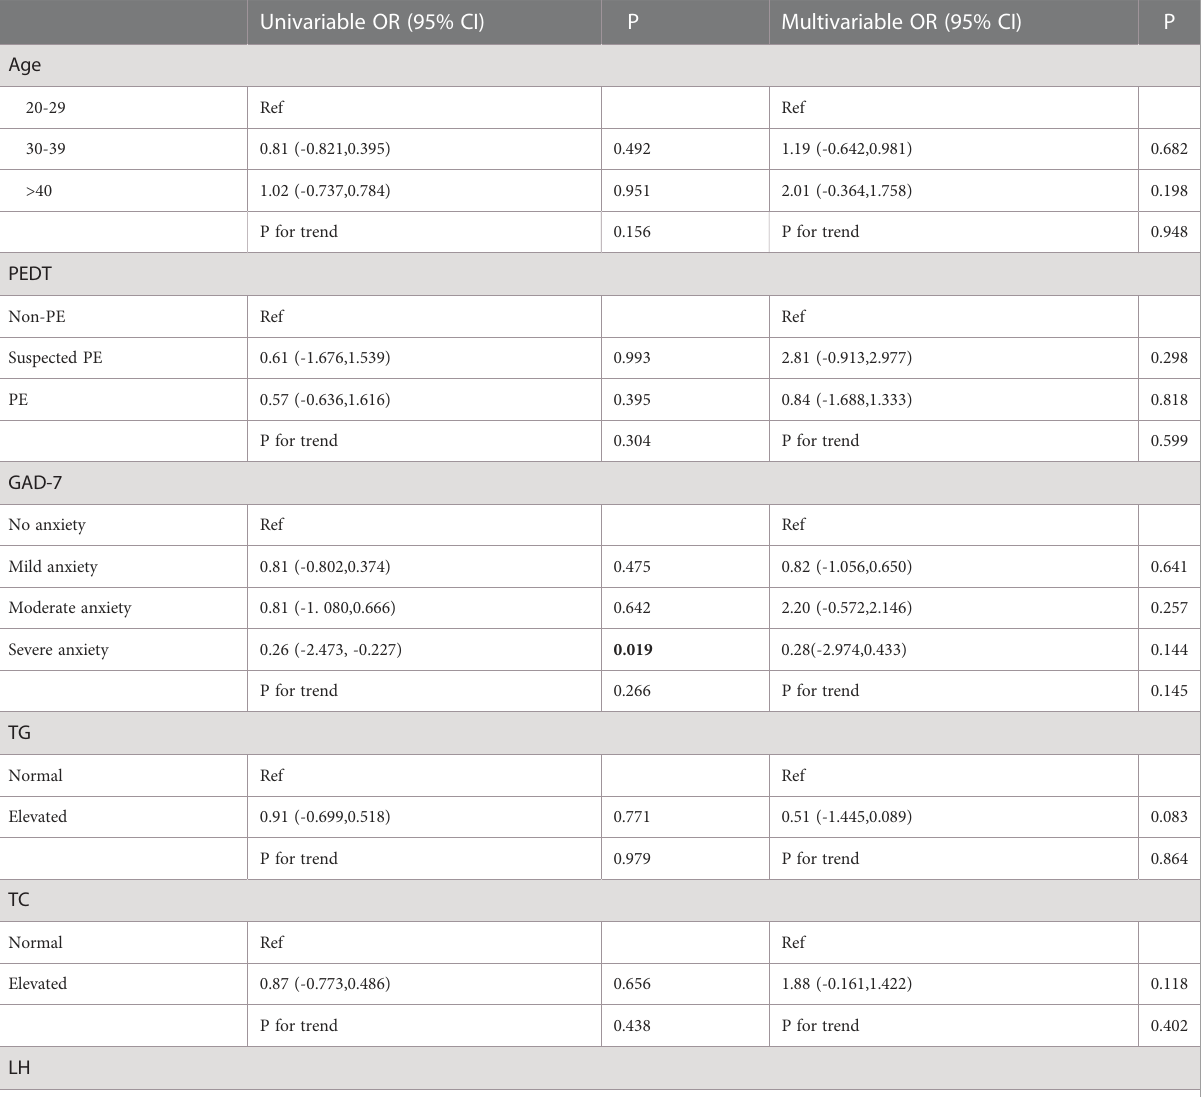
TABLE 4.2 Univariable and multivariable ordinal logistic regression analysis among Non-DMED